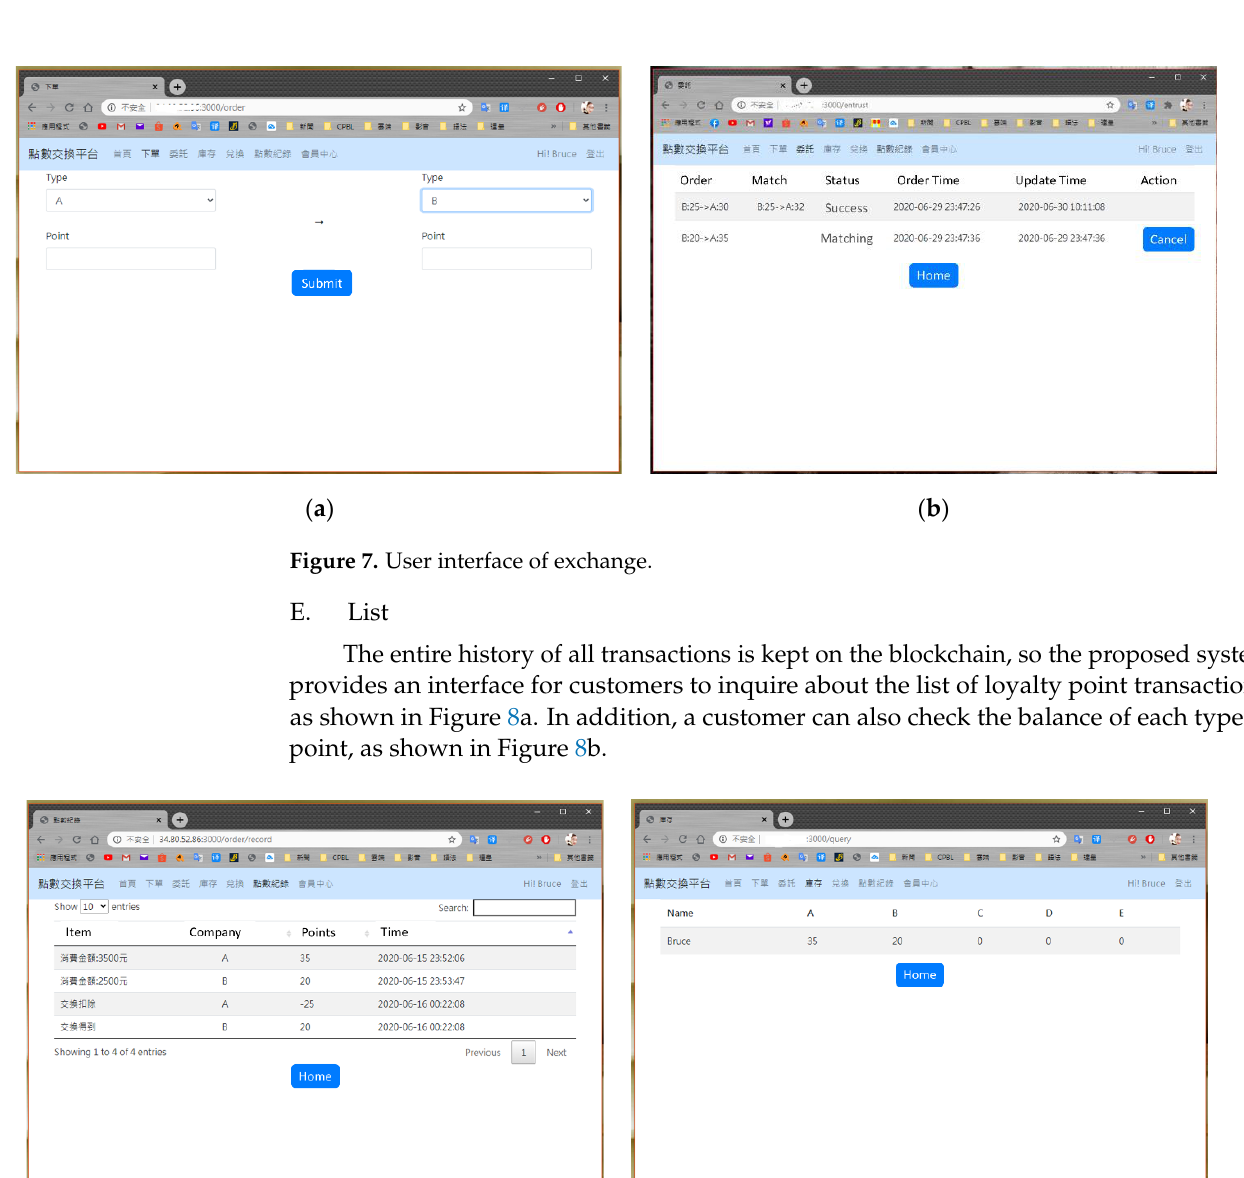
12 ( c ) Figure 6. User interface of redemption. D.